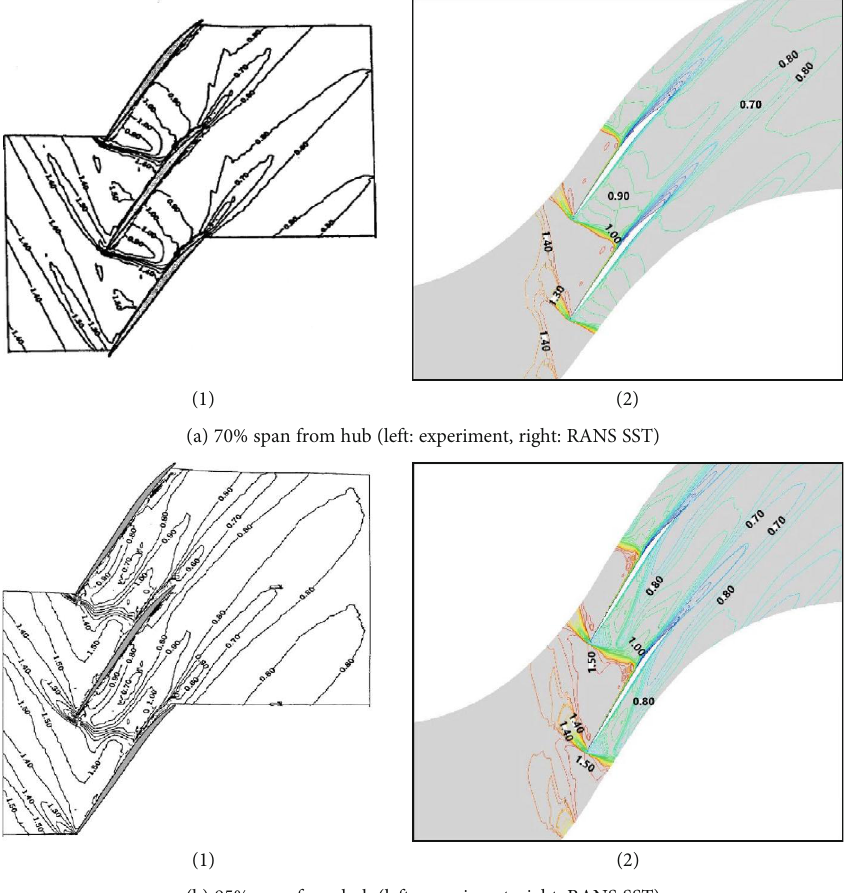
Figure 13: Comparisons of predicted and measured relative Mach number at two typical blade spans for near-peak e ffi ciency